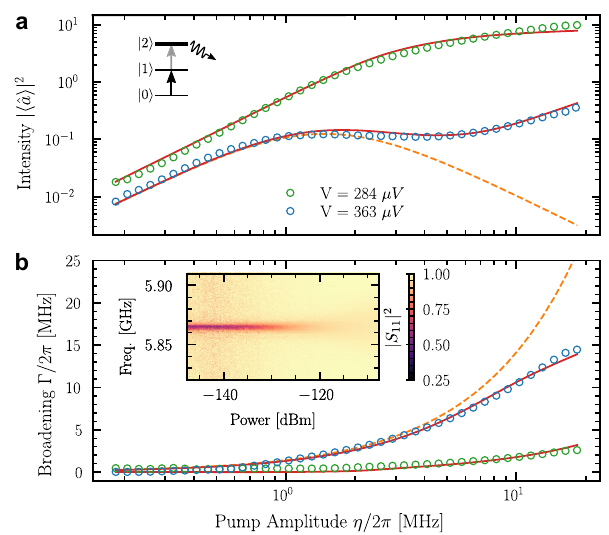
Fig.3|QuantumZenodynamics.a Evolutionofthesquaredmeanamplitude ∣ 〈 â 〉 ∣ 2 in the mode as a function of the pump amplitude η for two different bias voltages. In the absence of Zeno effect, ∣ 〈 â 〉 ∣ 2 is quadratic with the pump amplitude (green data). When the voltagelies in the rangewherethe quantum Zeno dynamics limits thedynamictooneofatwo-levelsystem,weobserveaclearsaturation(bluedata). Thesolidredlineshowsthepredictionofamasterequationtakingintoaccountthe different absorption rates for different Fock states (see SI). The dashed line shows the expectation for an ideal two-level system. The calibration of the measured intensityisdetailedintheSI. b Evolutionofthepowerbroadening Γ asafunctionof the pumpamplitude. The resonancespectrashown inthe inset are fi tted using the ffiffiffiffiffiffiffiffiffiffiffiffiffiffiffiffiffi p κ 2 +2 Γ 2 usual formula for a two-level system, which predicts a fwhm (see SI), where κ is the total loss rate. Power broadening is important in the case of Zeno dynamics (blue data) and negligible otherwise, except at very high power (green data).Thesolidanddashedlinesshowtheresultofthemasterequationsimulation and the expectation for an ideal two-level